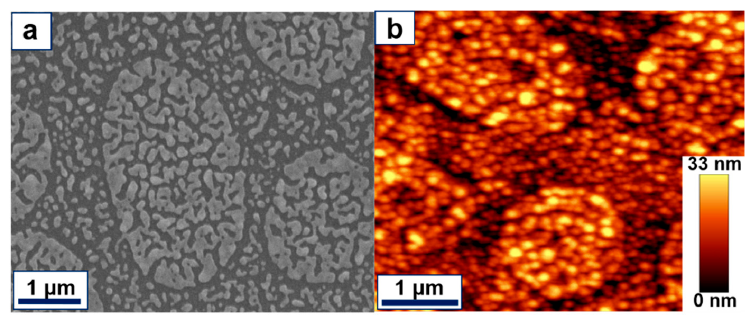
Figure 4. ( a ) SEM and ( b ) AFM images of Sample C.